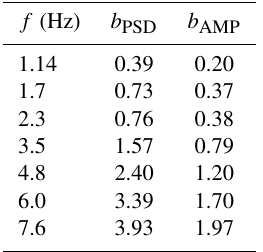
Table 1. Calculated b values for the PSD amplitude decay, b PSD , and corresponding b values of the signal amplitude decay, b AMP . The latter was derived from b PSD by the application of factor